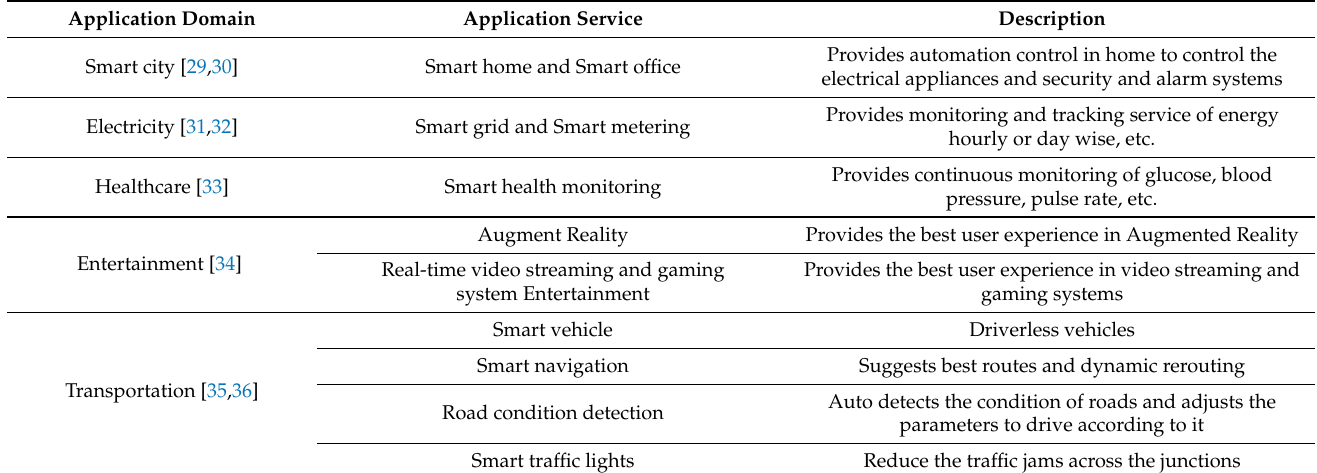
Figure 3. The architecture of Fog computing. Table 3. Examples of Fog